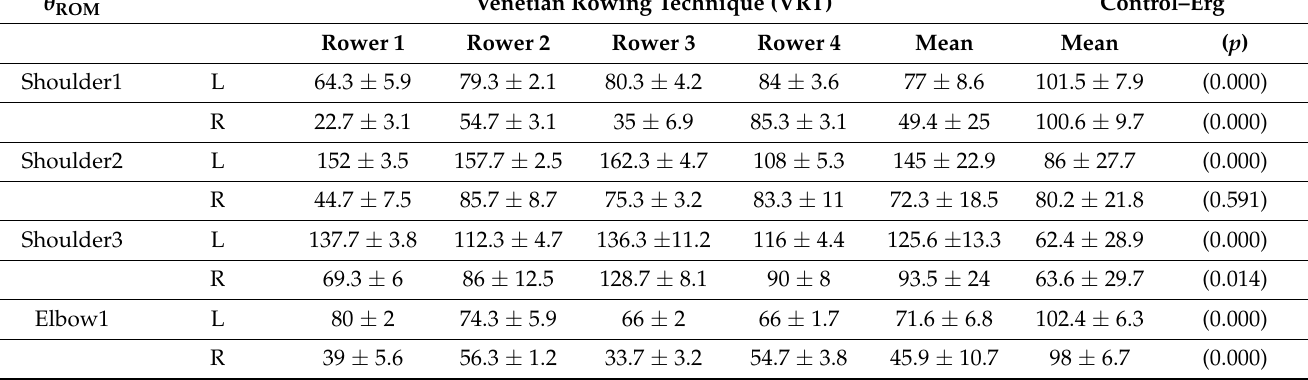
Table 7. The range of motion values, θ ROM , of the shoulder and elbow angles measured for the Venetian style rowing technique, in degrees, ± 1 s.d., for the individual rowers 1–4, their mean, and its equivalent mean value for standard ergometer rowing, with p -value for these two means reported in